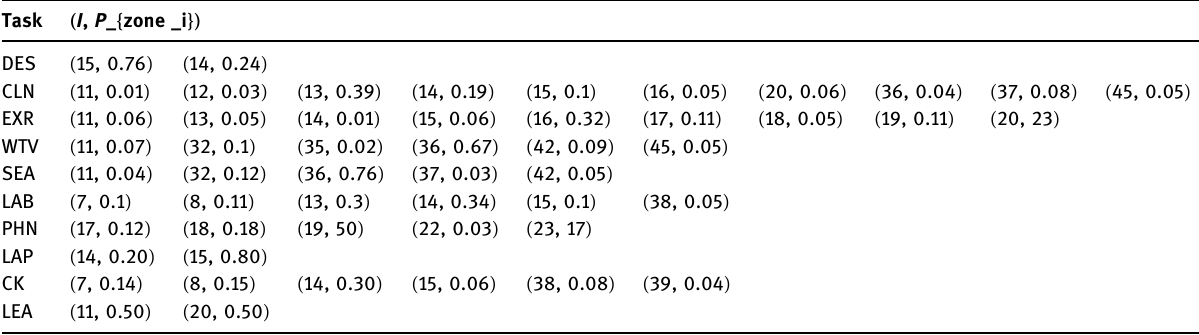
Table 1: The set of zones and their corresponding probabilities of occupancy obtained for each task